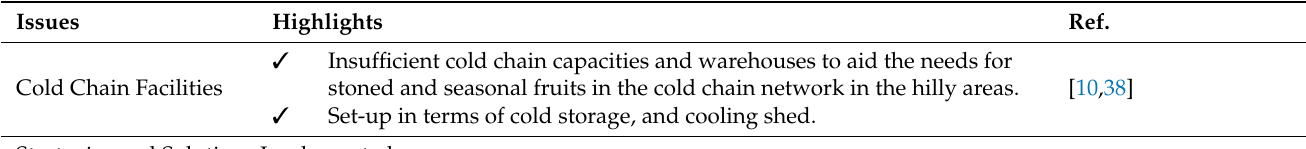
Table 5. Compiled cold storage issues in kiwi in Bageshwar District and strategies and solutions implemented.